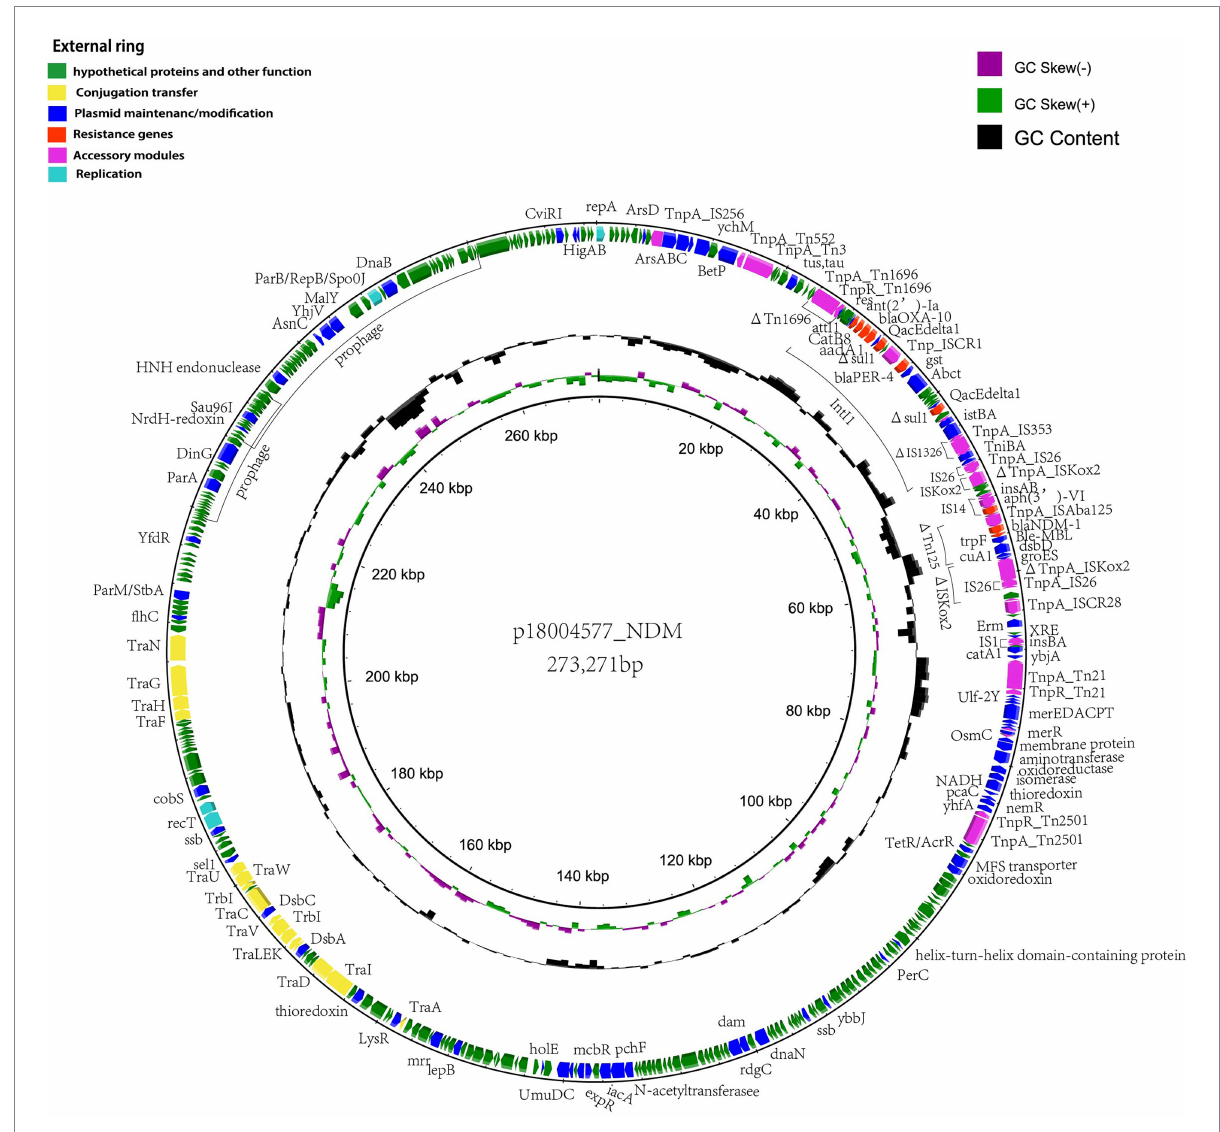
FIGURE 4 Schematic representation of the genetic organization of p18004577_NDM. The outermost ring shows the coding sequences of the plasmid. Each coding sequence is color coded according to its predicted function, as shown in the figure legend. The two inner rings represent the GC content and the GC skew graph,